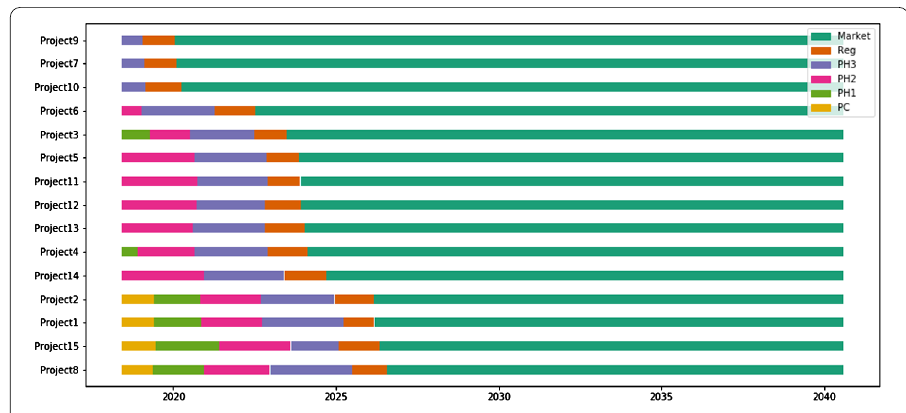
Figure 2 Timelines for the development of the projects in the portfolio